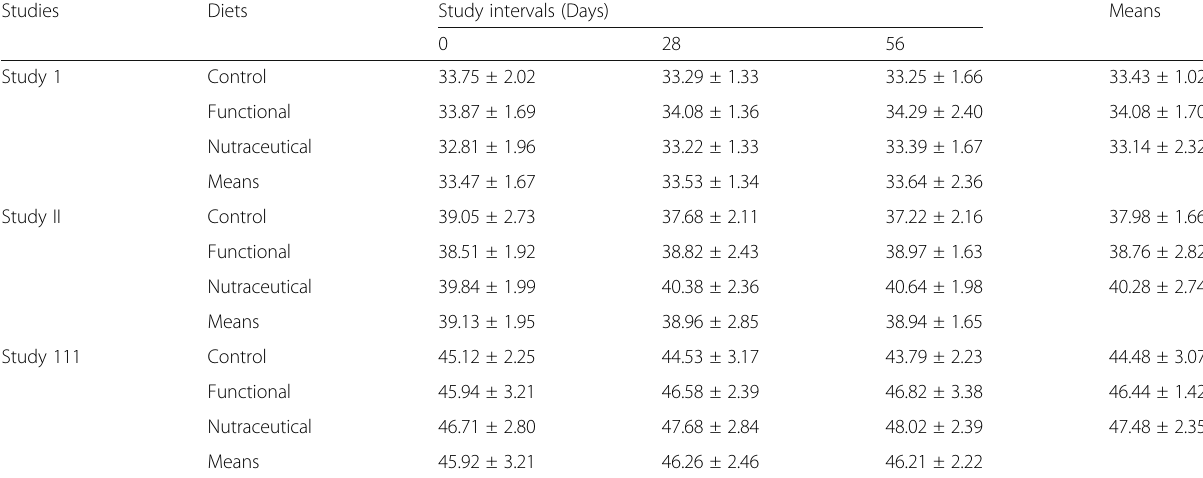
Table 7 Effect of diets and study intervals on HDL-c (mg/dL) of rats in different studies Studies Study intervals